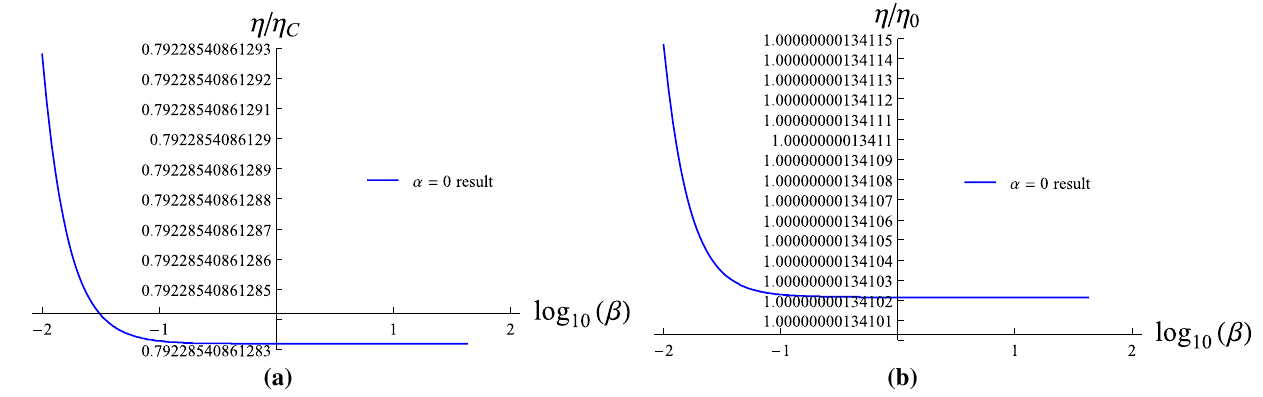
Fig. 2 For the case α = 0. a The ratio η/η C vs. log 10 (β). b The ratio η/η 0 vs log 10 (β). (Here, we have chosen the values n = 4 , q = 0 . 1 , b = 1 ,